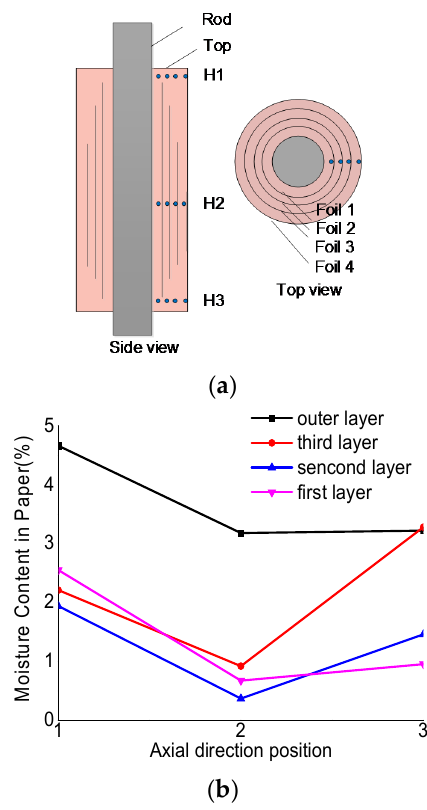
Figure 10. Sampling point of moisture in the core. ( a ) View of sample point model; ( b ) Distribution of moisture in paper of bushing core.